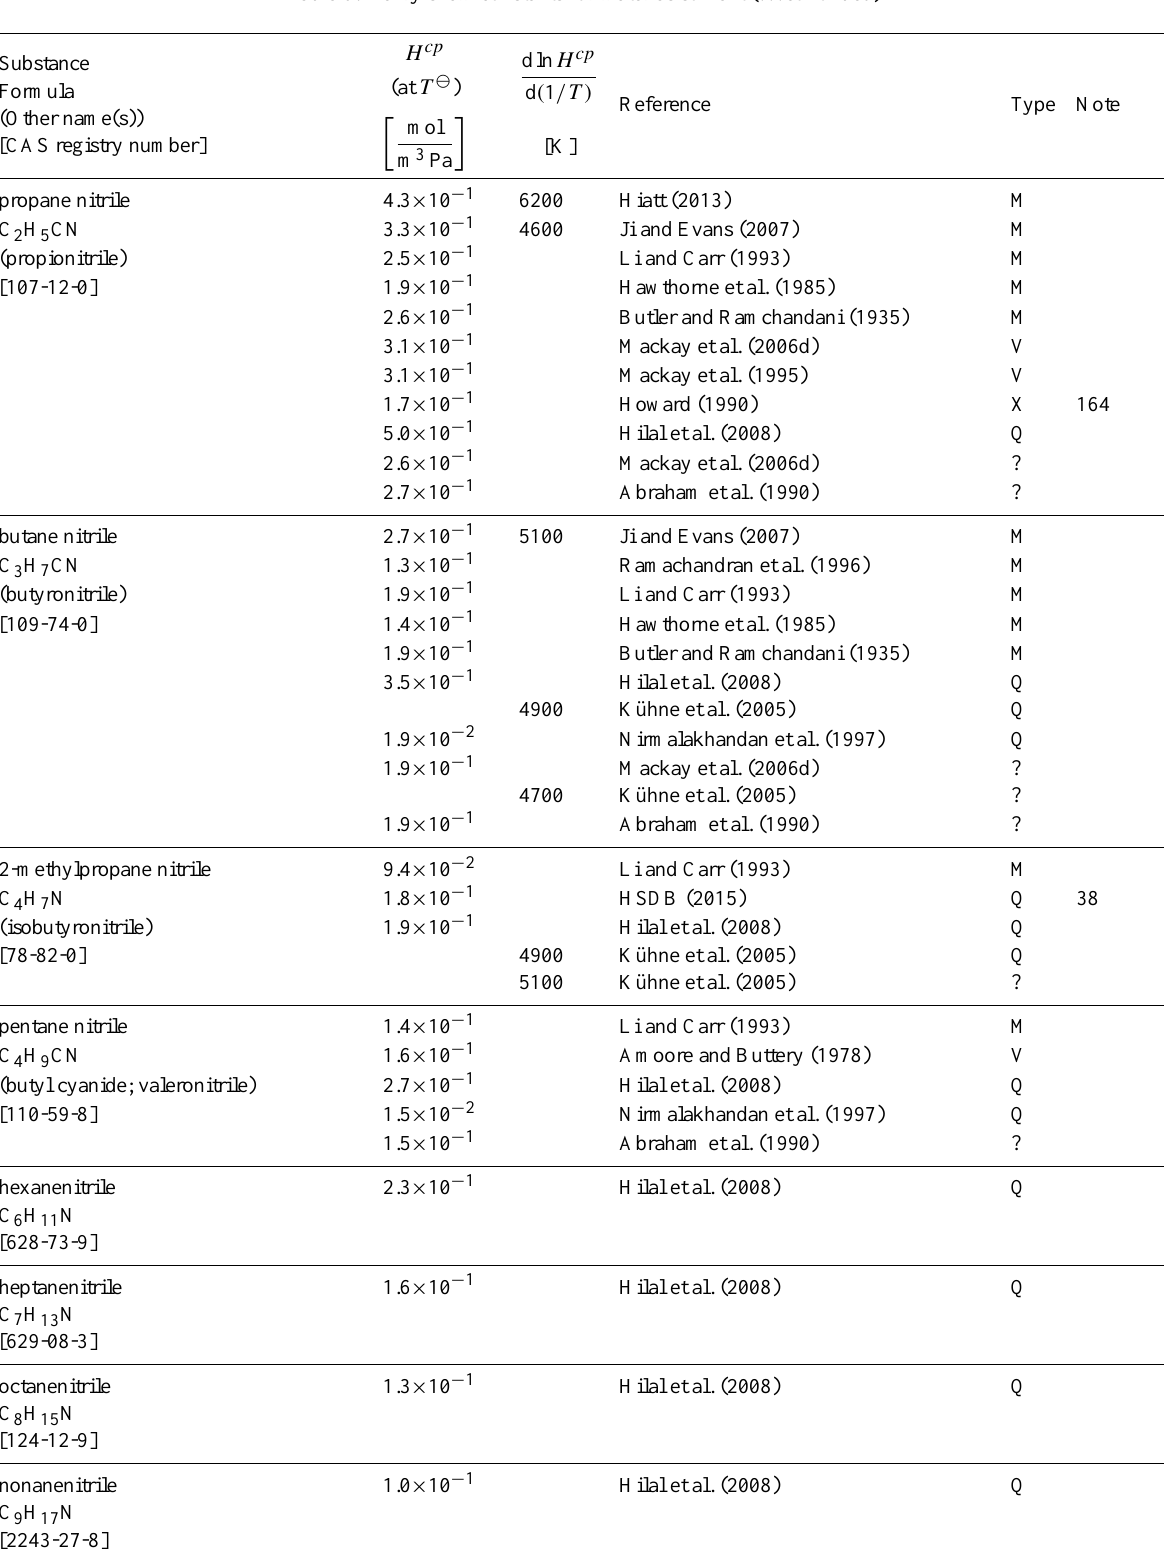
Table 6: Henry’s law constants for water as solvent